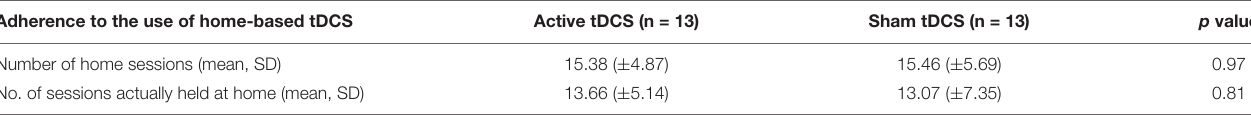
TABLE 7 | Adherence to the use of home-based tDCS assessed by recording the number of sessions performed at home (maximum number = 20 sessions). Adherence to the use of home-based tDCS Active tDCS (n = 13) Sham tDCS (n = 13) p value Number of home sessions (mean, SD)